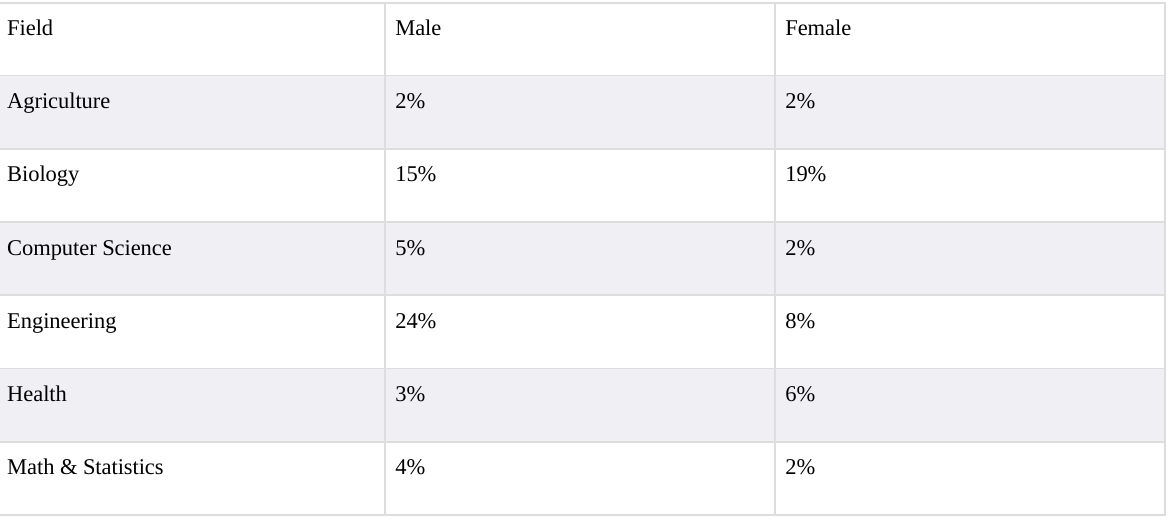
Table 1. Earned doctorates are more likely to be in STEM fields for men than